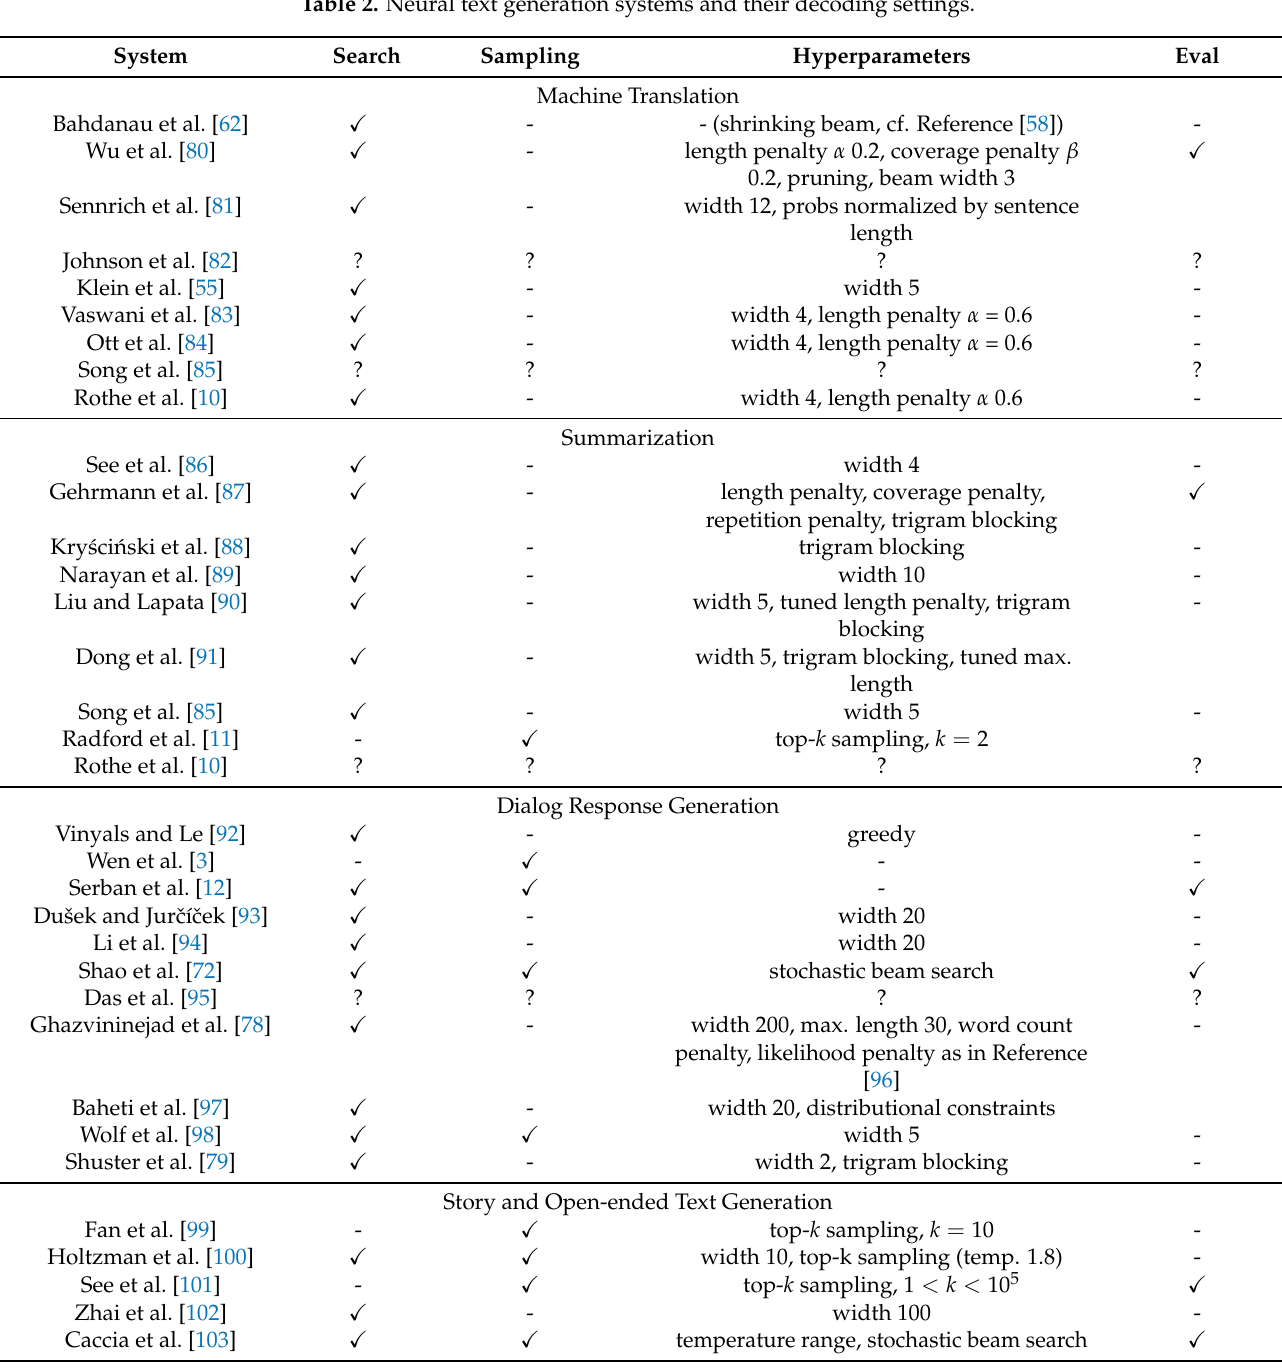
Table 2. Neural text generation systems and their decoding